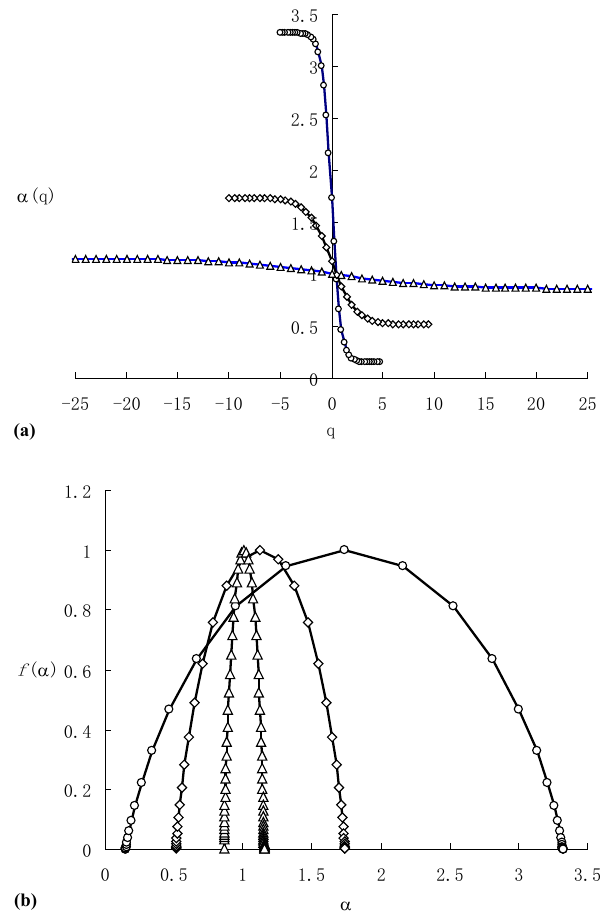
Fig. 1. (a) Singularity functions α(q) obtained from the normal de Wijs model with d = 0 . 1 (triangles), 0.3 (diamonds) and 0.45 (dots), respectively. Value ranges of q are different for models with differ- ent values of d . (b) The results of spectra functions f (α) for differ- ent values of d